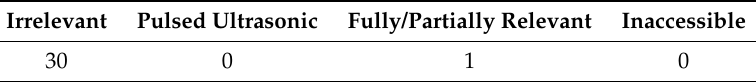
Table 2. Number of irrelevant, partially- or fully-relevant papers, as well as papers that display ultrasonic cure monitoring, but with a pulsed ultrasonic approach, with respect to the search terms “ultrasound spectroscopy” and “cure